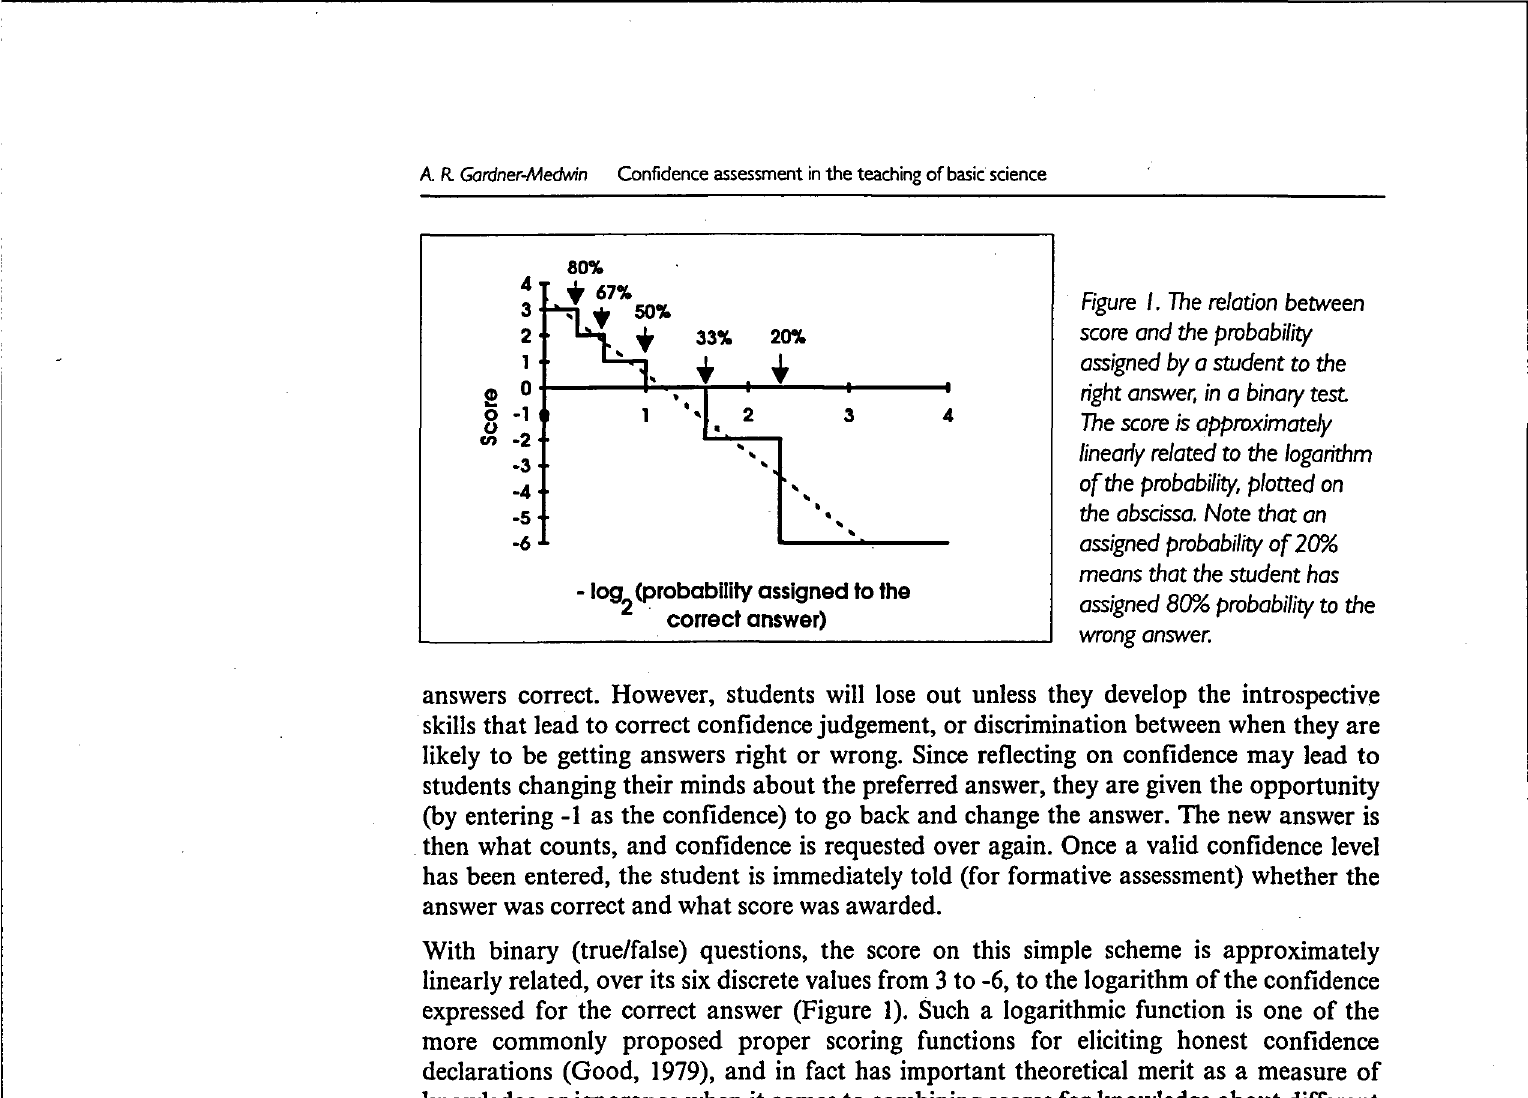
• log (probability assigned to the correct answer)